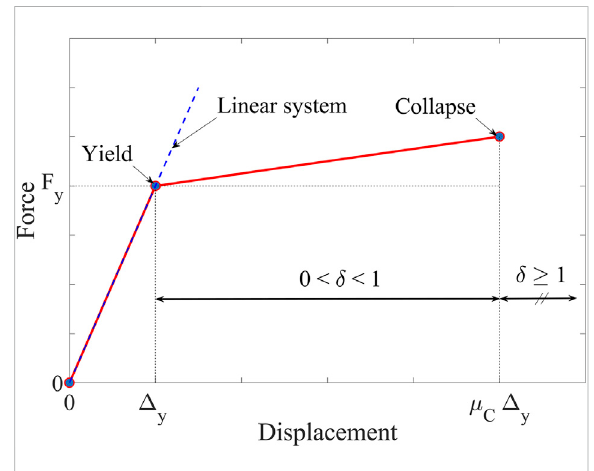
FIGURE 1 Ranges of δ in the force-displacement curve of a nonlinear